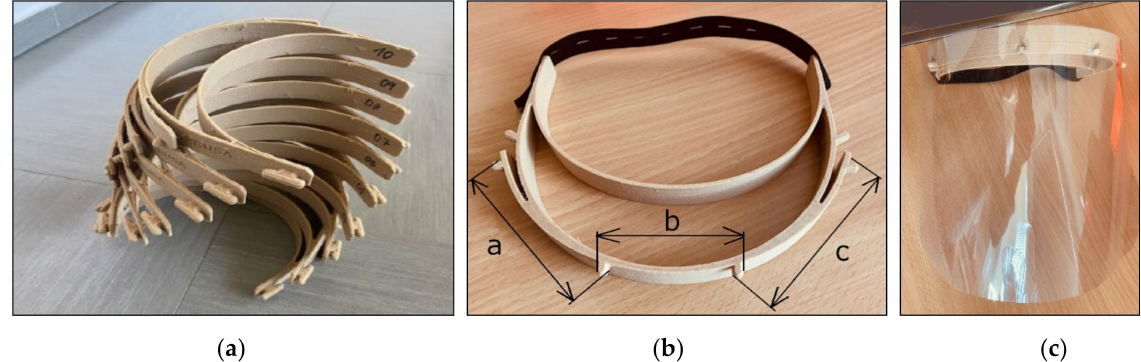
Figure 10. Face shield frames for PLA BioWOOD Rosa 3D filament. ( a ) the batch of printed frames; ( b ) the distance between fasting pins; ( c ) faceshield frame with